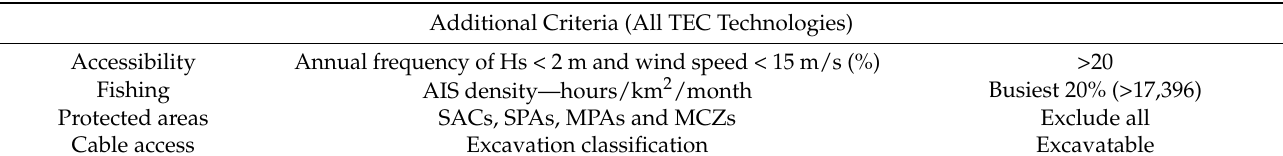
Table 10. Details of additional site selection inputs for identification of optimum tidal energy sites.